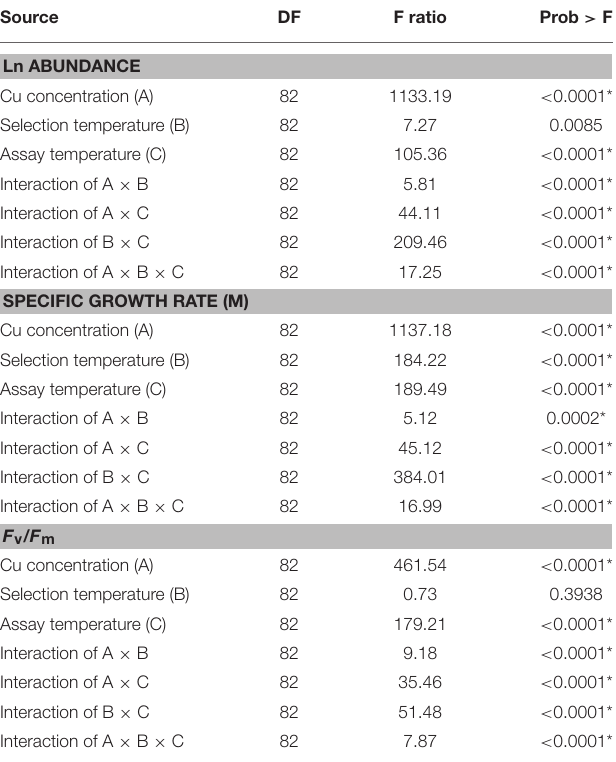
TABLE 3 | Statistical results of linear mixed-effects modeling analysis of covariance with Ln abundance, specific growth rate ( µ ), and F v / F m of Chaetoceros tenuissimus as dependent variables, selection temperatures (26 and 30 ◦ C), Cu concentrations, and assay temperatures (26, 30, and 35 ◦ C) as fixed effects, and the biological replicates within treatments as a random effect on intercepts (DF: Degrees of freedom, F ratio: the model mean square divided by the error mean square, Prob > F: The p -value for the test).